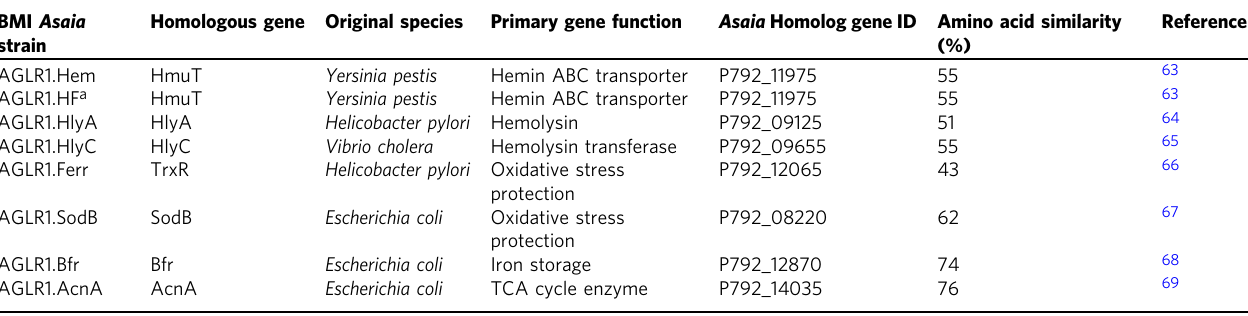
Table 1 Homologous BMI promoters in related bacterial species used to make putative blood-meal induced GFP strains of